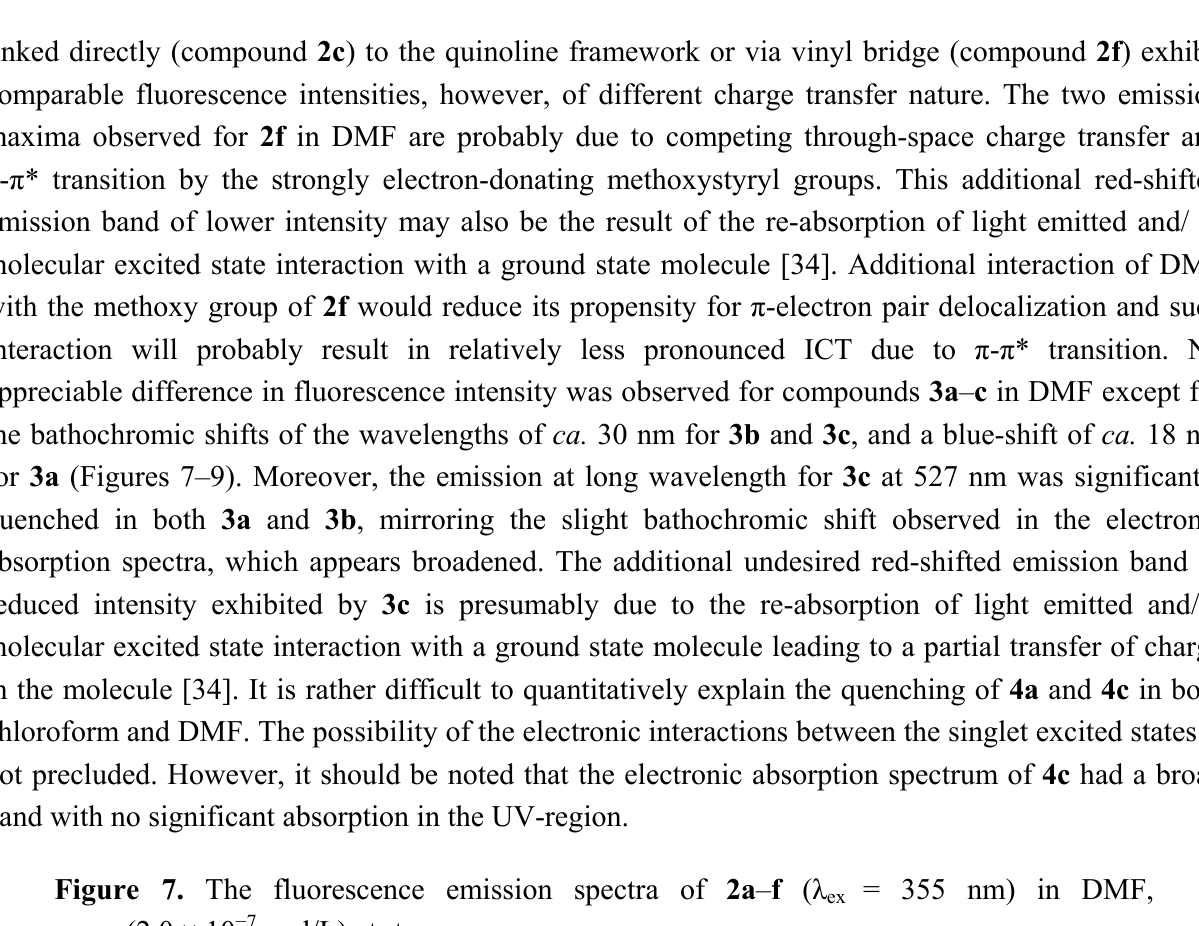
= 355 nm) in DMF, ex